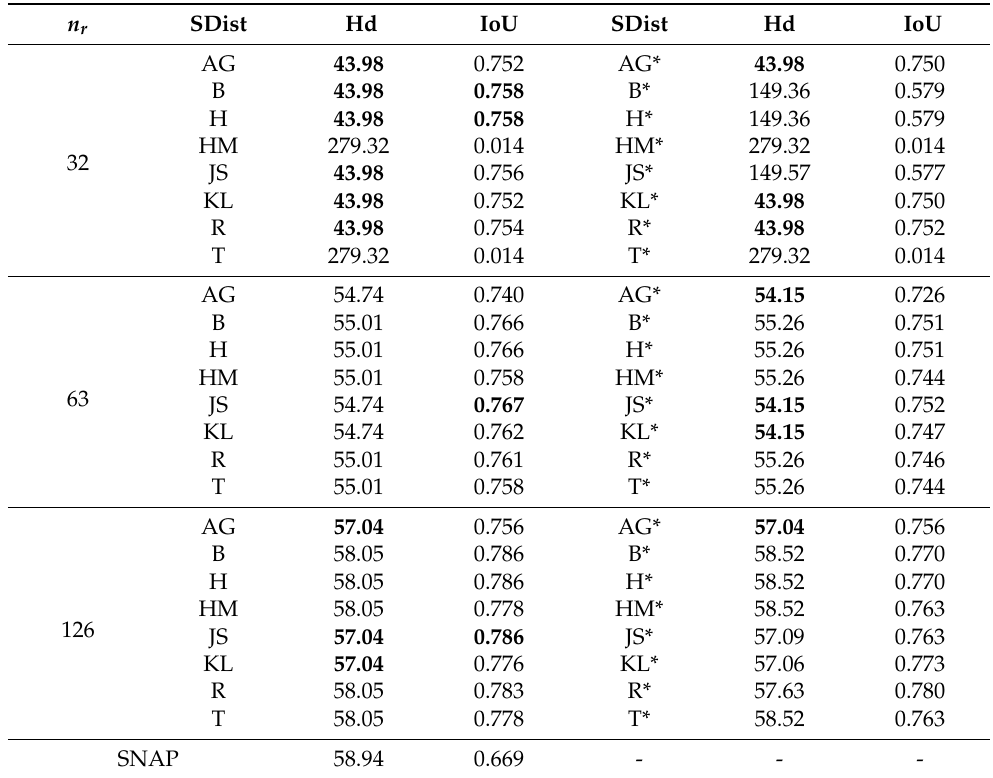
Table 8. Quality measure results for the image in Figure 3 bottom left, for each stochastic distance (SDist).